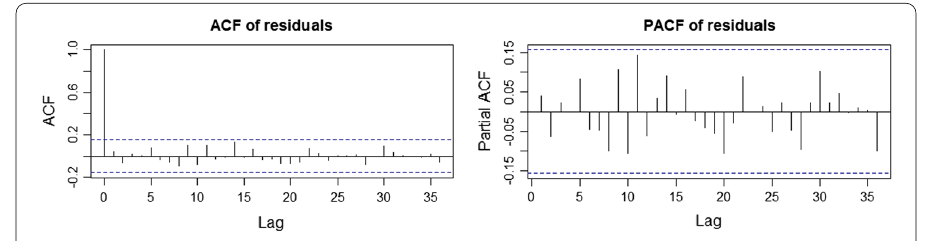
Fig. 5 The plot of autocorrelation and partial autocorrelation of residuals from model in Eq.